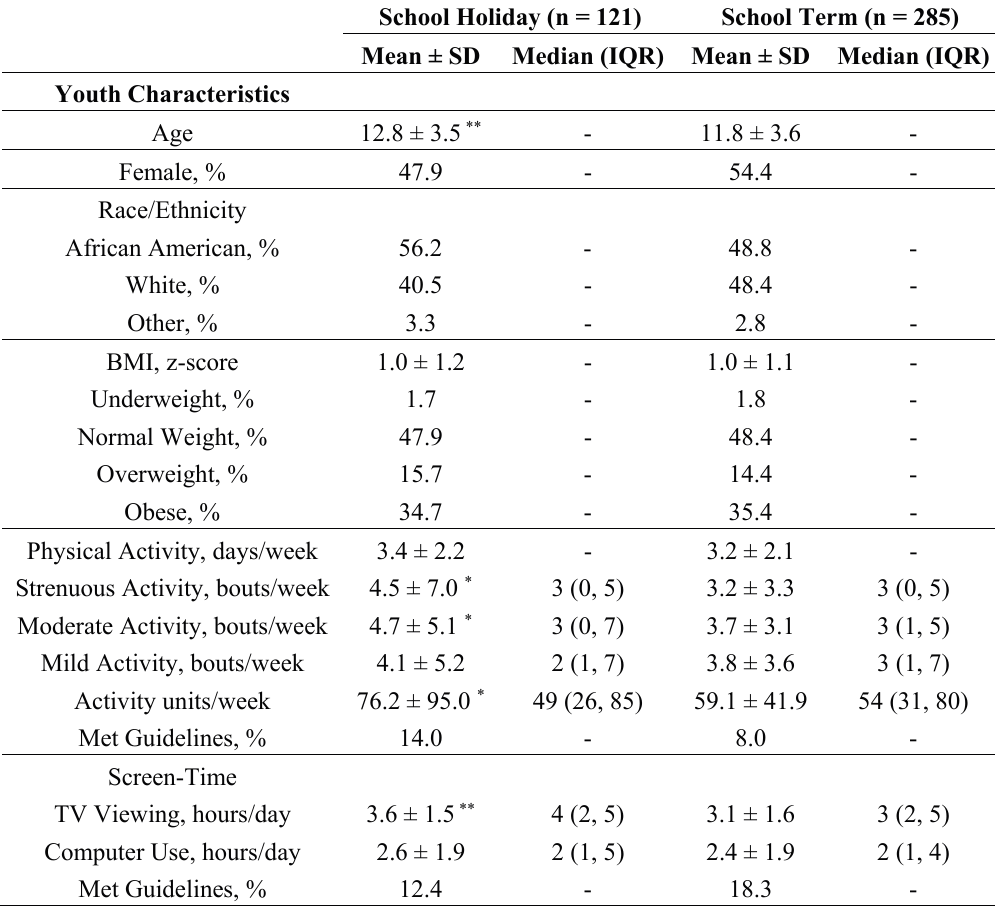
Table 1. School holiday vs. school term: characteristics of youth and